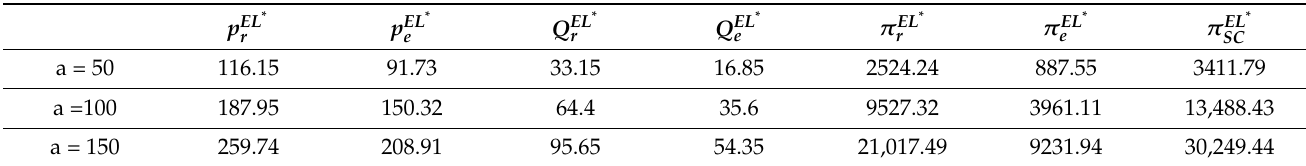
Table 9. Optimal decisions of channel members under the EL game—Case